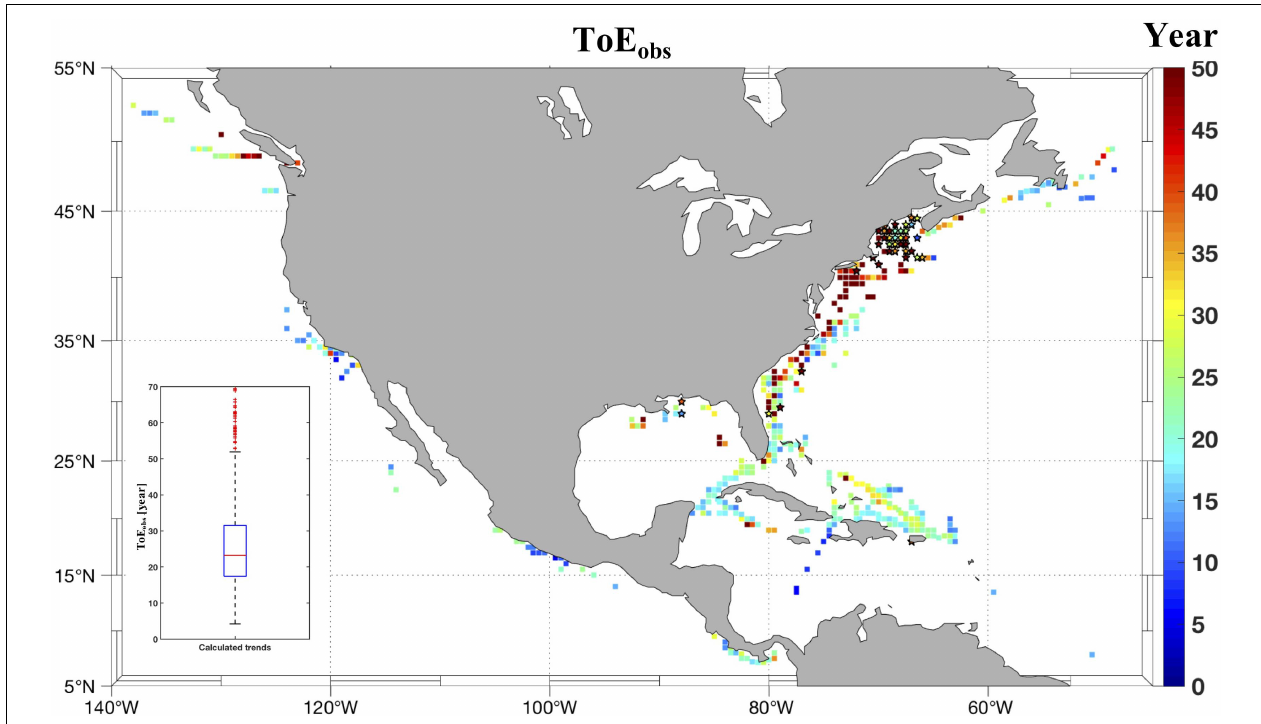
FIGURE 2 | ToE obs of ƒ(CO 2 , sw ) in the North American coastal margins. Note, the pentagram symbols highlight the negative trends, and the corresponding ToE represents the absolute value. The inserted panel is the boxplot of ToE [the red line inside the blue rectangle (the interquartile range) represents the median, the “whiskers” above and below the rectangle show the minimum and maximum ToE values, and the red crosses are the